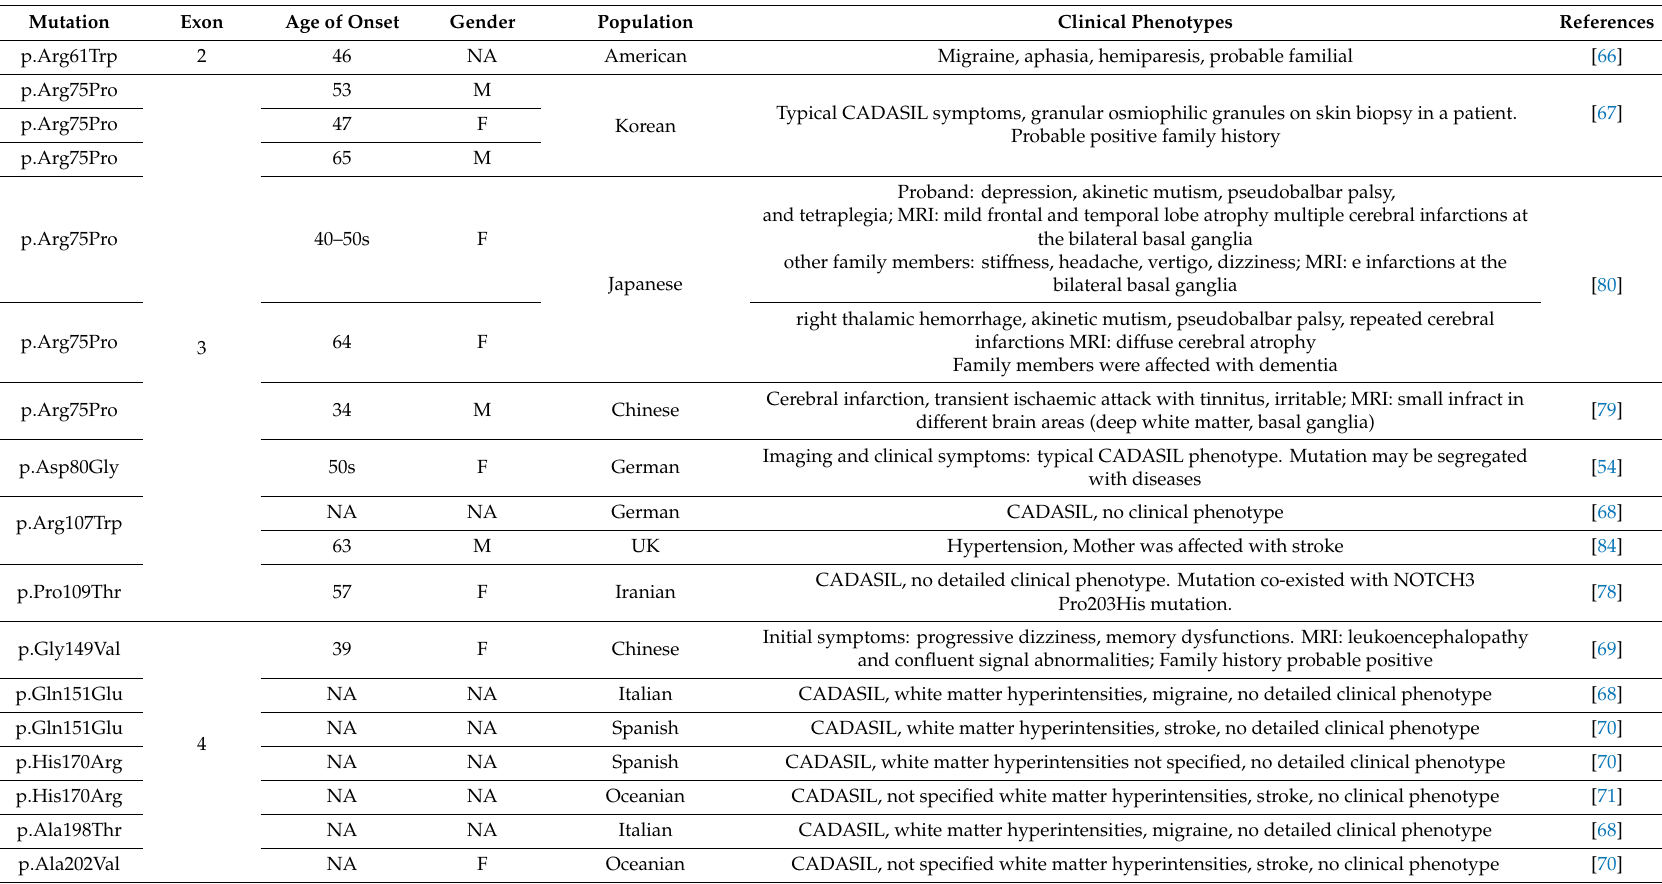
Table 2. Various typical clinical CADASIL-causing variants in NOTCH3 that do not a ff ect cysteine amino